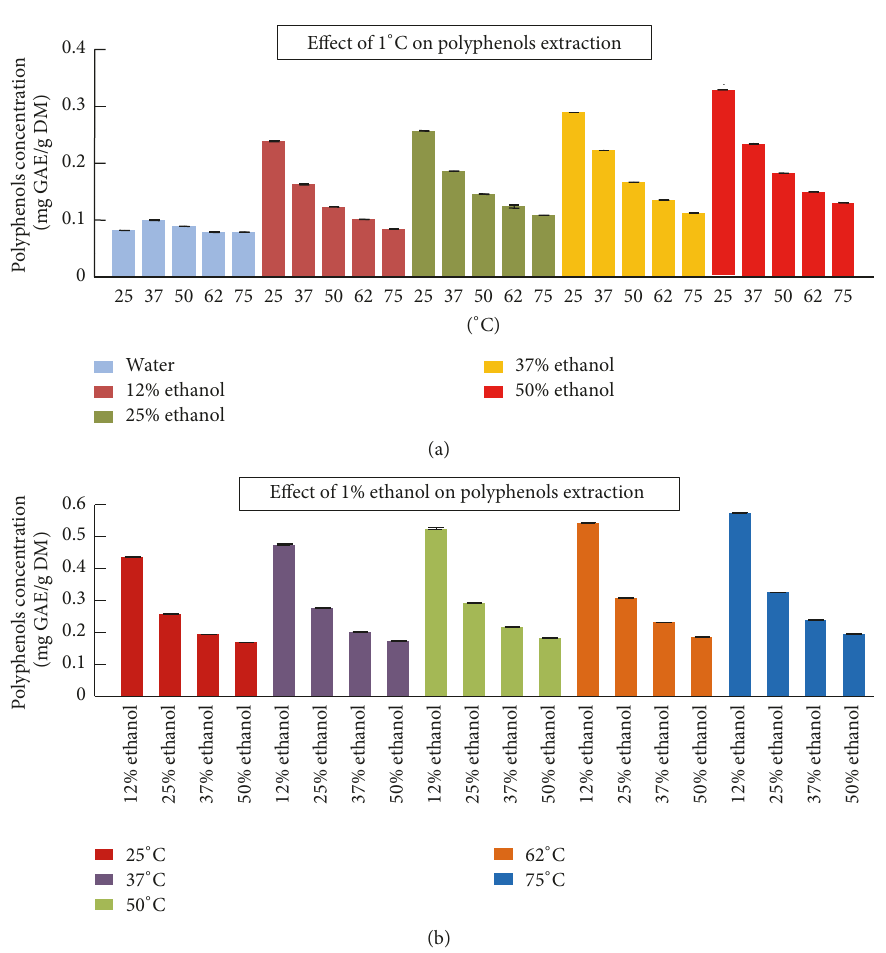
Figure 3: The effect of (a) 1 ∘ Celsius and (b) 1% ethanol on the phenolic compounds extraction.